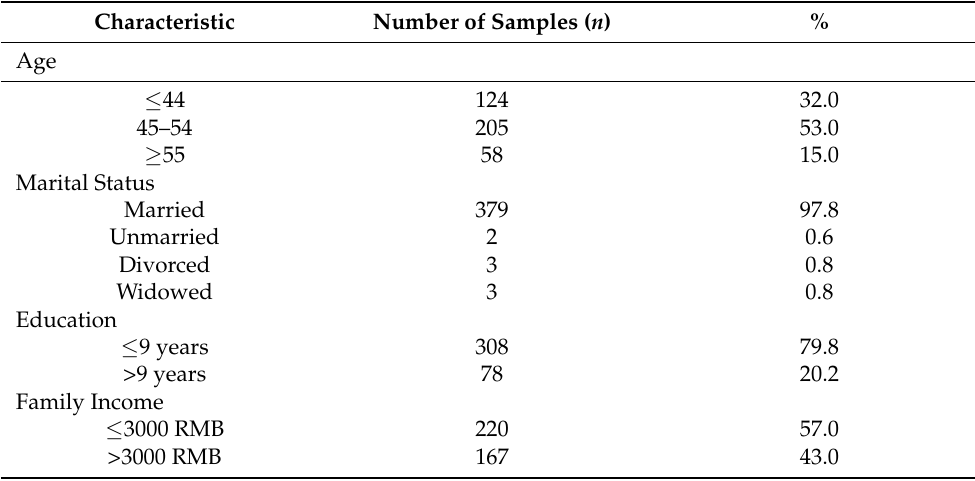
Table 1. Demographic Characteristics of the Study